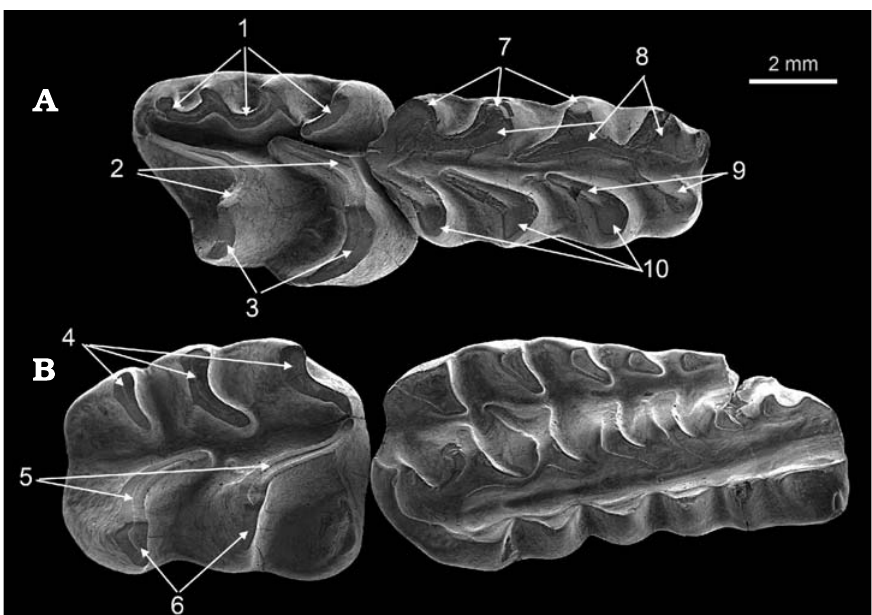
Fig. 14. The upper and lower left molars of multituberculate mammal Lambdopsalis bulla Matthew, Granger, and Simpson, 1928